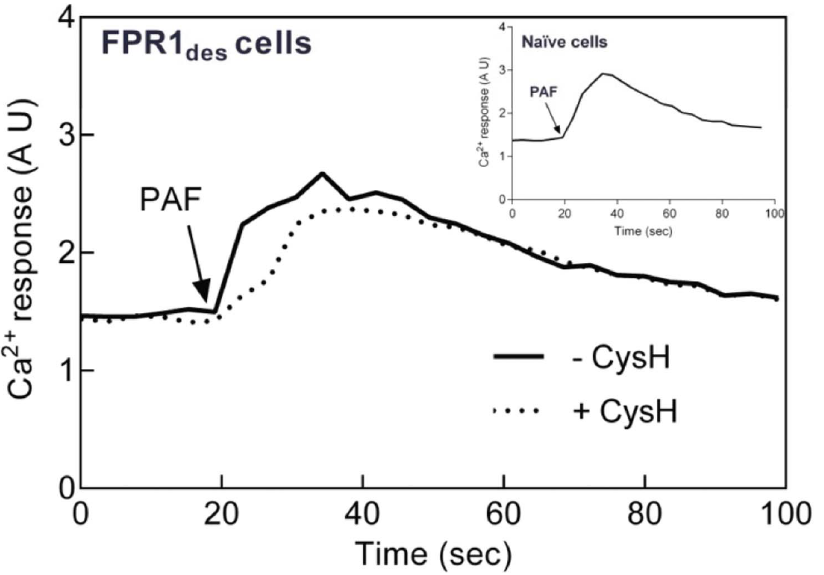
Figure 3. Intracellular Ca 2 + response triggered upon reactivation of FPR1 des by PAF is not cyclosporin H sensitive. FPR1 des neutrophils (desensitized with 0.1 nM fMIFL) loaded with Fura-2 (2 6 10 6 /ml) were activated by PAF (1 nM final concentration) in the absence (solid line) or presence (broken line) of the FPR1 specific antagonist cyclosporin H (1 m M added 30 sec before PAF). The changes in fluorescence were followed using dual excitation of Fura-2 at 340 and 380 nm, respectively, with an emission wavelength of 510 nm. For comparison, a PAF-induced intracellular Ca 2 + response is shown for naı¨ve neutrophils (inset). A representative experiment is shown, n=3. Abscissa, time of study (sec); Ordinate, relative change in hello Ca 2 + ] i (arbitrary units,